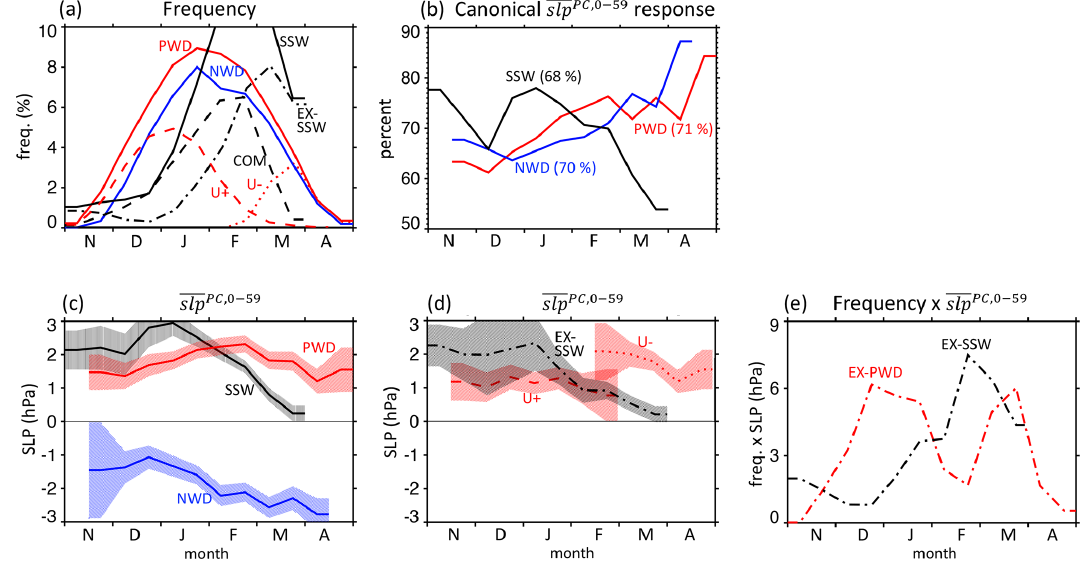
Figure 7. Seasonality of event frequency and surface response in the model. Shown are histograms of (a) the frequency of events (%), (b) the PC , 0 − 59 PC , 0 − 59 percentage of cases that slp has the expected sign ( > 0 for SSWs and PWDs; < 0 for NWDs), (c–d) slp , and (e) the product PC , 0 − 59 of frequency and slp averaged over all cases within one bin for the shown events as a function of the day of the year (horizontal axis, November–April). PWD wave driving threshold (cid:80) F (cid:48) is 12.9d, and bin-size is 15d. The partly hidden black curve for SSWs in Z crit (a) peaks at the end of February at ∼ 13%. Shadings in (c, d) show the 95% confidence intervals determined from a t test. Black is for SSWs, red is for PWDs, and blue is for PWDs. Continuous lines show all events of one class (SSWs, PWDs, or NWDs), dashed red lines in (a, d) are EX-PWD U + events, dotted red lines in (a, d) are EX-PWD U − events, dashed black lines in (a) are common events (COM), and dashed-dotted lines in (a, e) are EX-PWD (both U + and U − ) or EX-SSW